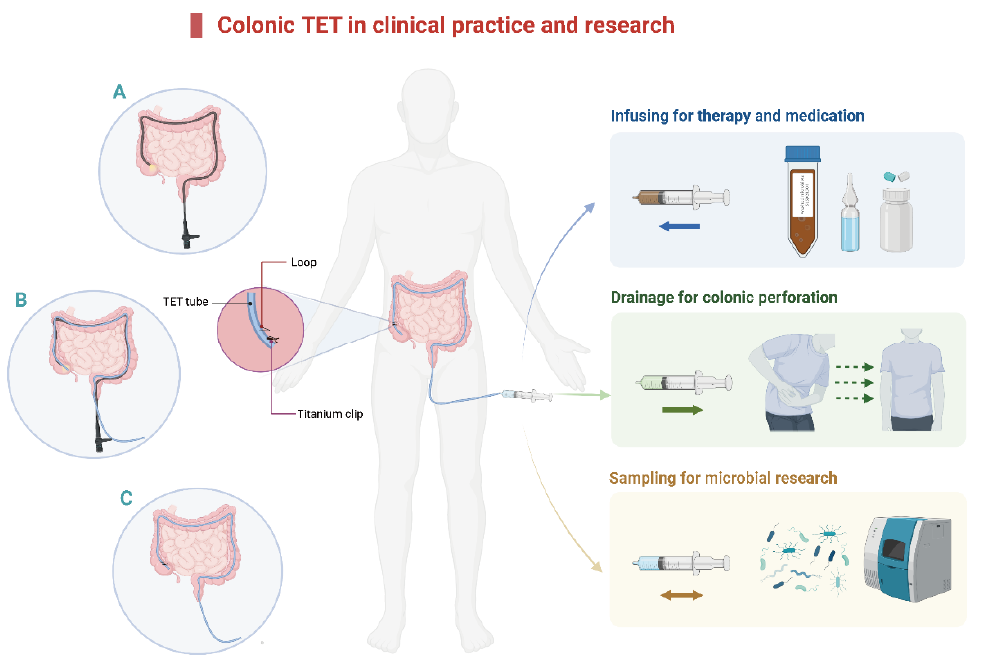
Figure 1. The diagram of colonic TET in clinical practice and research. ( A ). Insert the colonic TET into the endoscopic channel when the endoscope reaches the target location, then remove the endoscope. ( B ). Re-insert the endoscope and hold the TET tube in place. ( C ). Insert the titanium clip to fix the loop of the colonic TET tube onto the intestinal wall. TET: transendoscopic enteral tubing.